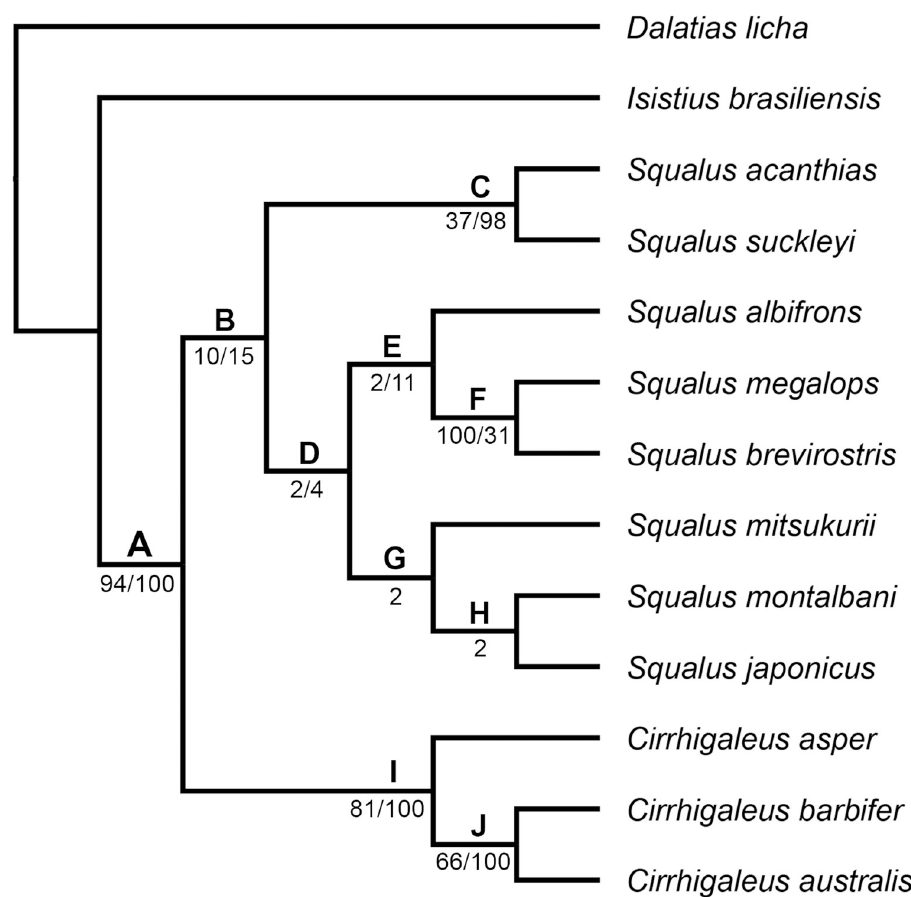
Fig 13. Strict consensus cladogram of the two equally most-parsimonious cladograms of 69.9 steps resulting from the analysis of 51 morphological characters (CI = 0.80; RI = 0.88). Relative Bremer support values are given below each